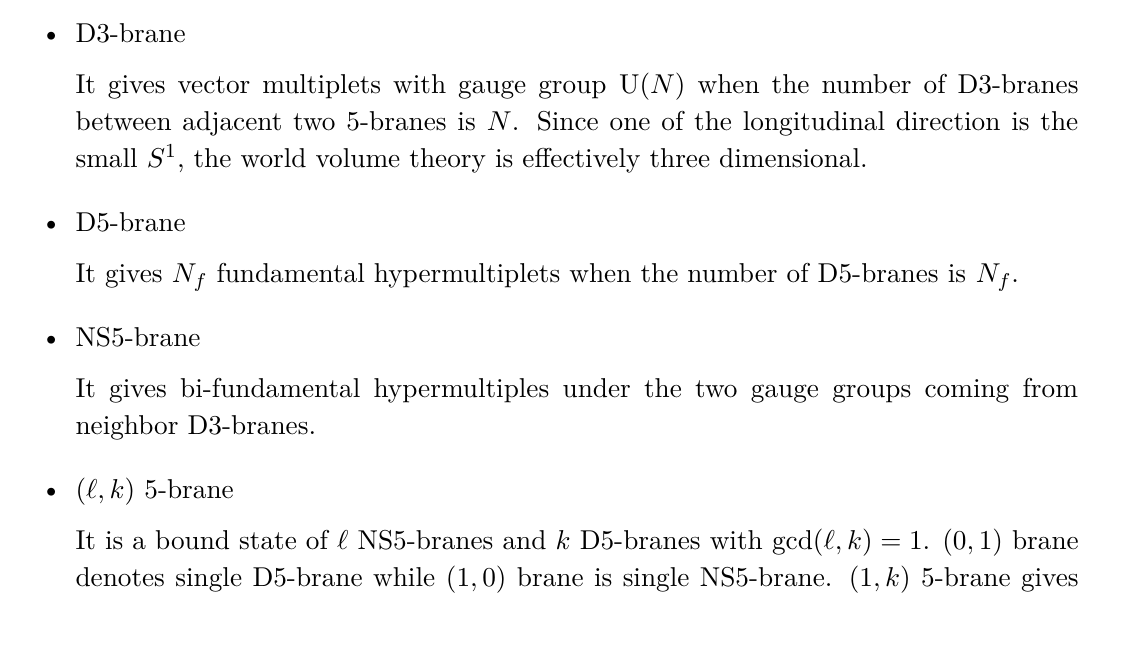
) U( N ) U( N ) 1 k 1 − k n × 2 k 2 − k 1 × · · · × n k n − k n − 1